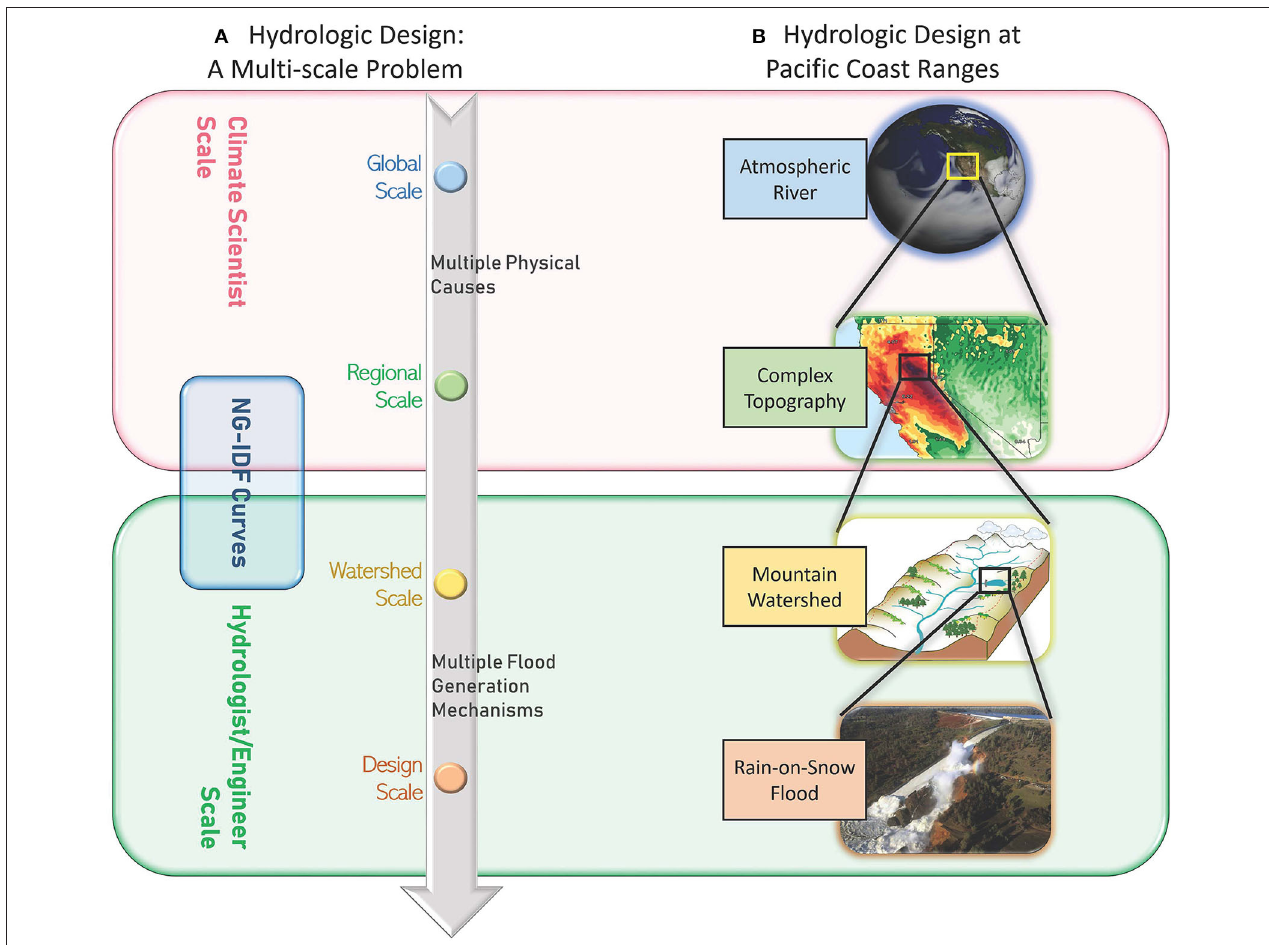
FIGURE 2 | (A) Illustration of hydrologic design under nonstationary climate: a multi-scale problem that links climate scientists, hydrologists, and engineers. (B) An example of a flooding event at the Sierra Nevada caused by rain-on-snow at watershed-scale and atmospheric river at global-scale.